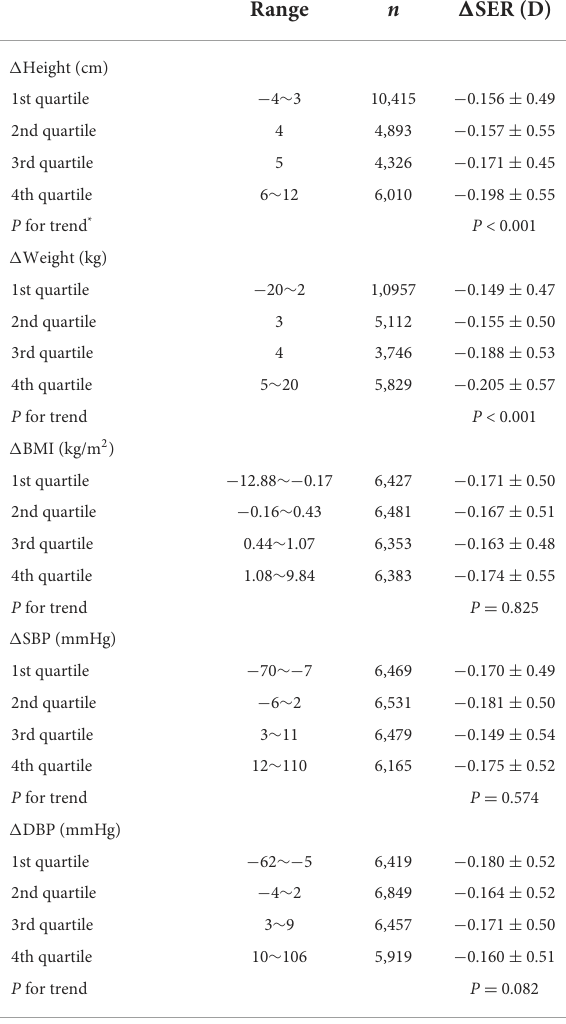
TABLE 5 Mean values of SER changes by quartiles of change in height, weight, BMI, SBP, and DBP.